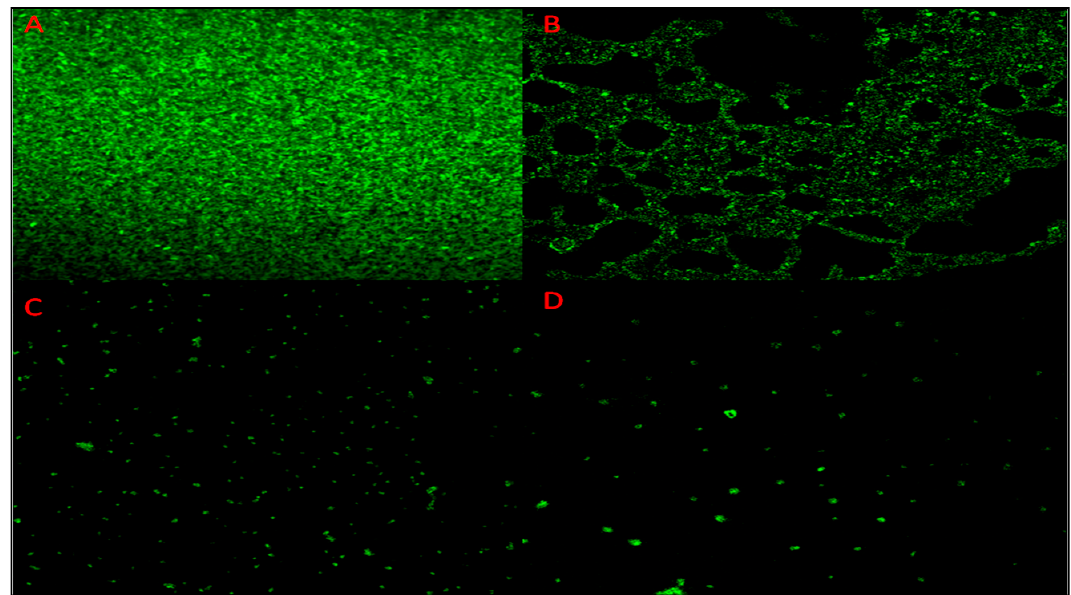
Figure 6. Confocal laser scanning microscopy (CLSM) images of the biofilm formed by P. aeruginosa PAO1 on the glass coverslips after 24 h of incubation. ( A ) Control; ( B ), ( C ), and ( D ) treated with 50, 100, and 150 µg/mL of TC-AuNPs, respectively.